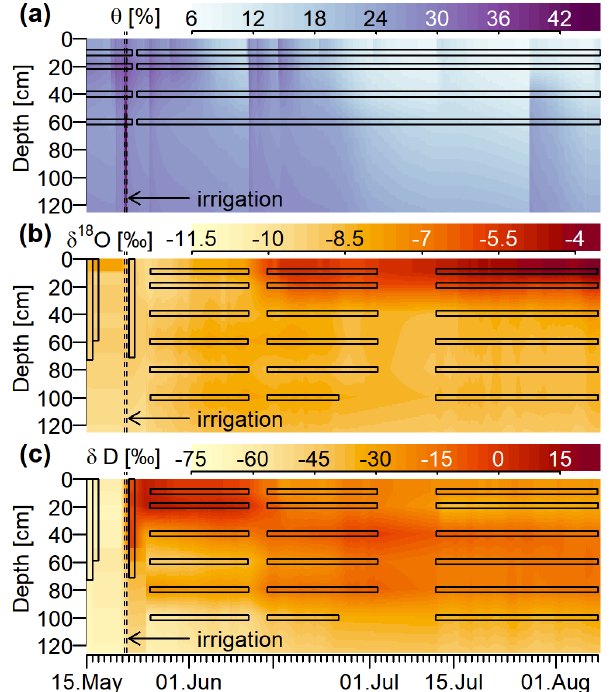
Figure A5. Input data for further RWU computations: spatially and temporally interpolated time series of (a) volumetric soil moisture, (b) soil δ 18 O and (c) soil δ D. Vertical bars represent actual observa- tions obtained by soil core measurements, and horizontal bars rep- resent observations measured with probes.